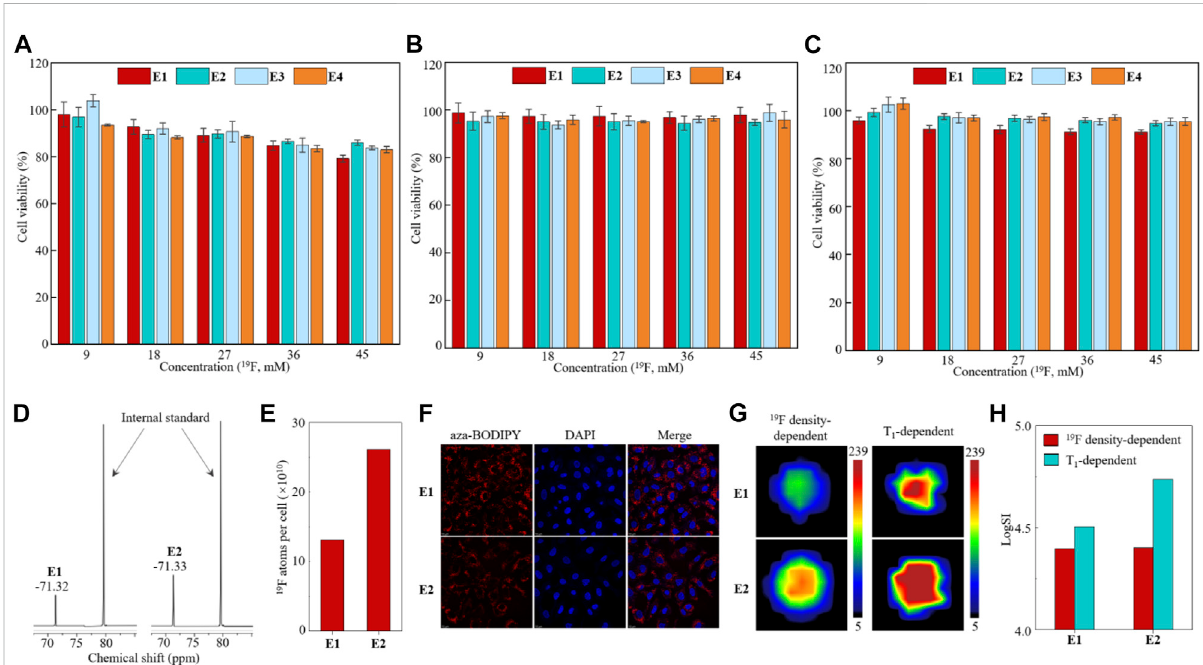
FIGURE 4 Cytotoxicity assay of nanoemulsions E1 – E4 in A549 cells (A) , MCF-7 cells (B) , and MDA-MB-231 cells (C) . Partial 19 F NMR spectra (D) and quantitative analysis of 19 F atoms ’ uptake in each cell (E) of nanoemulsion E1- and E2-treated A549 cell lysates. Confocal microscopy images